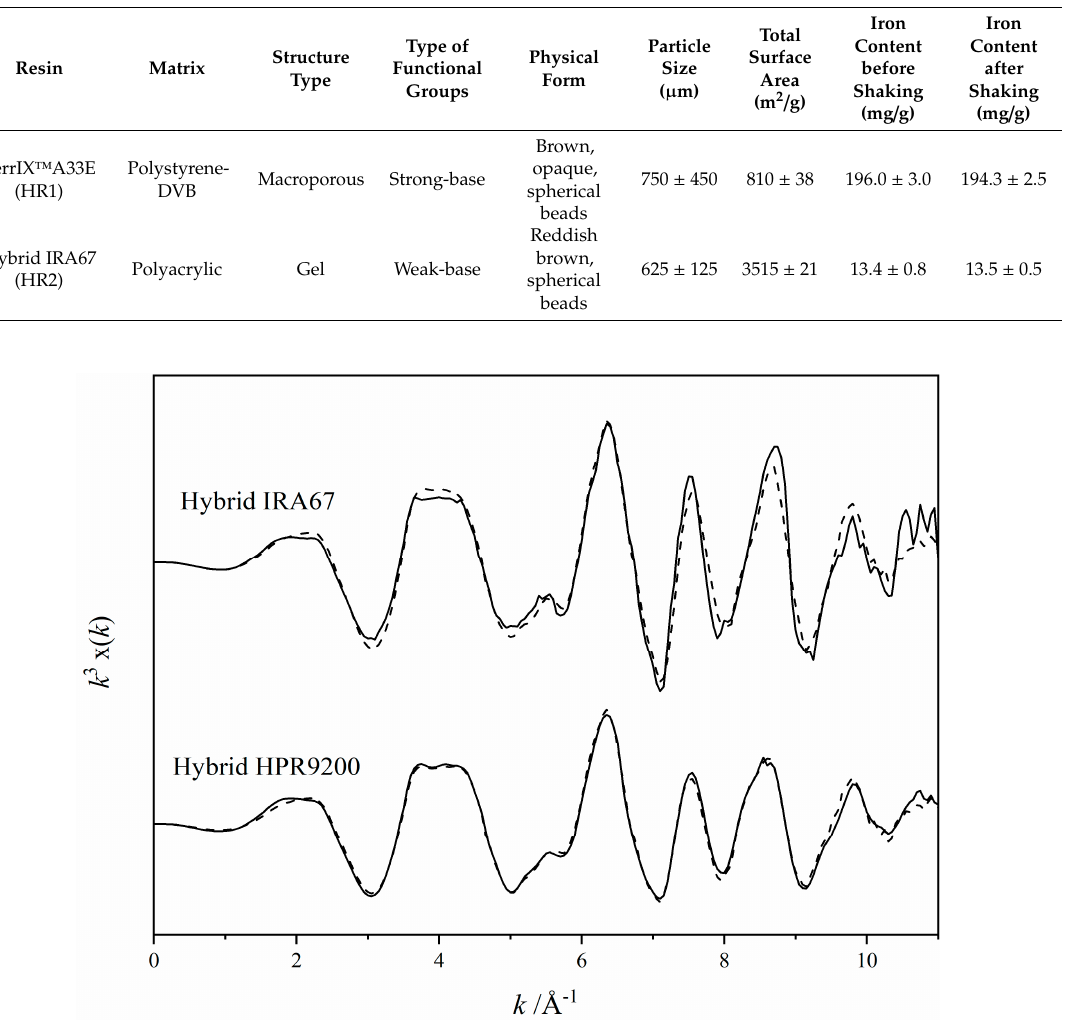
Figure 2. Results of linear combination fitting of X-ray absorption spectroscopy (XAS) spectra of reference compounds on the spectra of hybrid HPR9200 (HR1) and hybrid IRA67 (HR2). Black solid line and dashed line represent the normalized k 3 weighted XAS spectra and fit, respectively. HR1 is 100% goethite (R-factor: 0.01) and HR2 is 82 ± 4% goethite and 18 ± 2% hematite (R-factor: